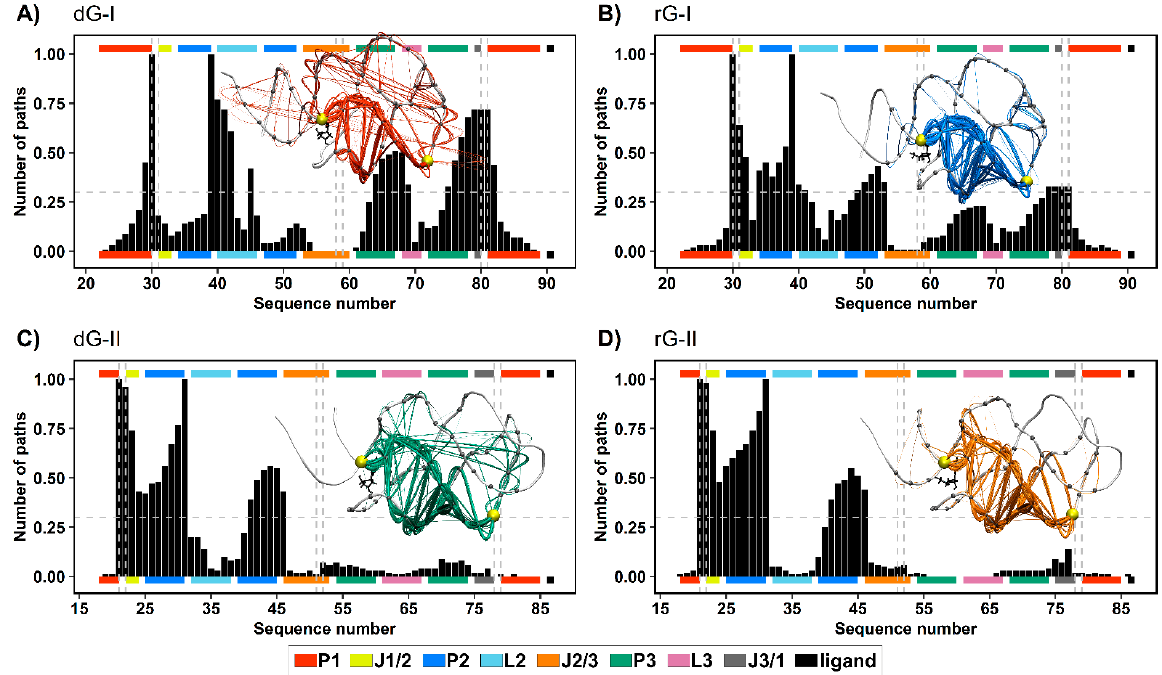
Figure 8. Normalized node degeneracy graph of 1000 shortest communication paths connecting A30(G21) and C39(A31) residues of 2′-dG-I ( A , B ) and 2′-dG-II ( C , D ) riboswitches classes bound to dG ( A , C ) and rG ( B , D ); and visualization of sub-optimal paths (with 200 shortest paths) in a correlation network. The aptamer substructures are depicted at the margin of the plots and colored according to the figure caption.